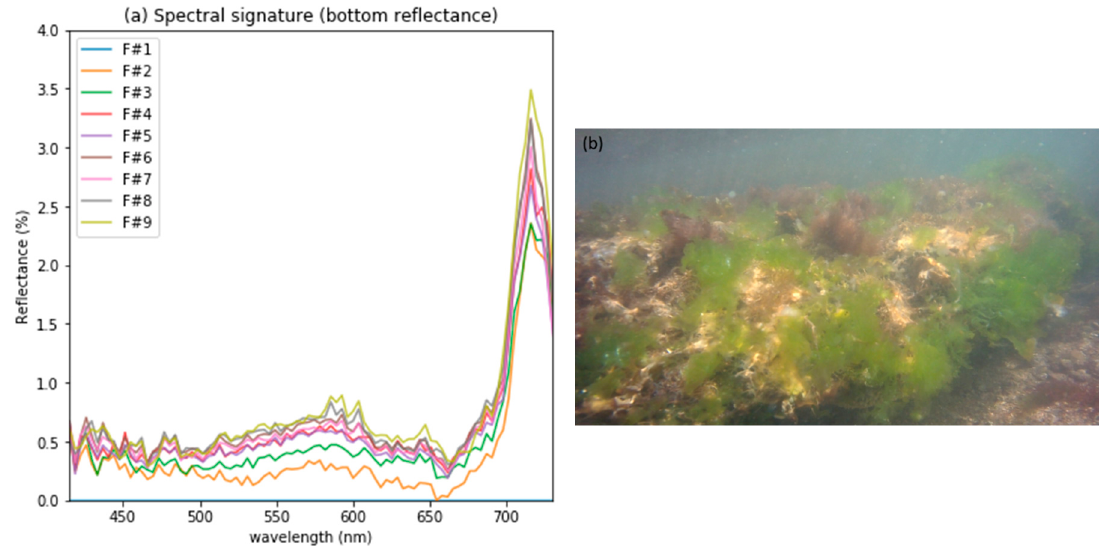
Figure 11. ( a ) Spectral signatures of bottom reflectance showing archaeological structures and ( b ) photograph of a permanently submerged stele of Er Lannic covered by green and brown algae.